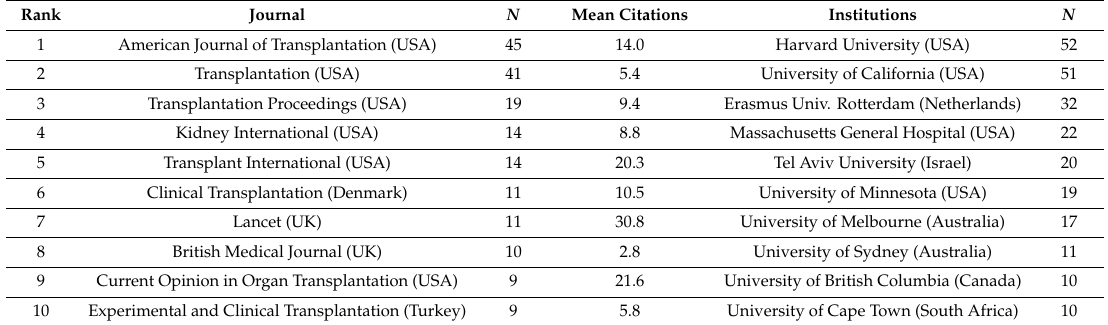
Table 2. Top ten most active journals and institutions on THBOR research.